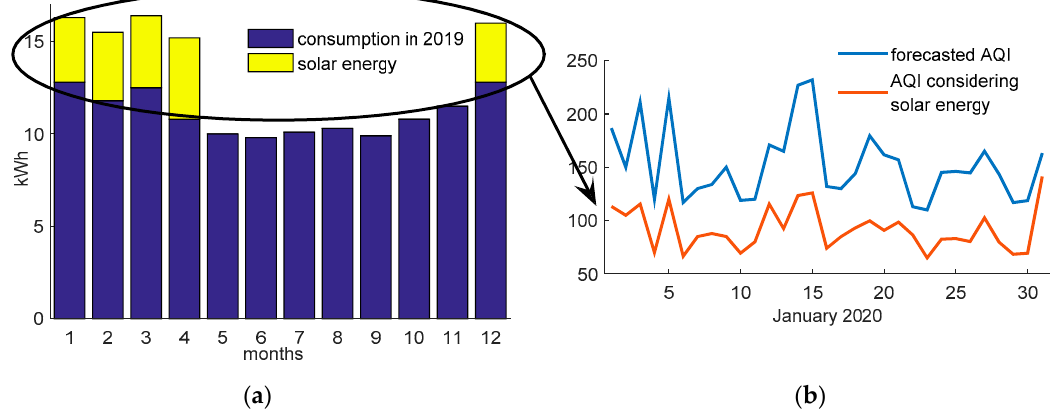
Figure 15. Correlation between renewable energy applications for domestic heating and AQI ( a ) Consumption of Sarajevo Canton with and without solar energy penetration, ( b ) Forecasted AQI by EMD-SARIMA hybrid model and AQI obtained considering solar energy.